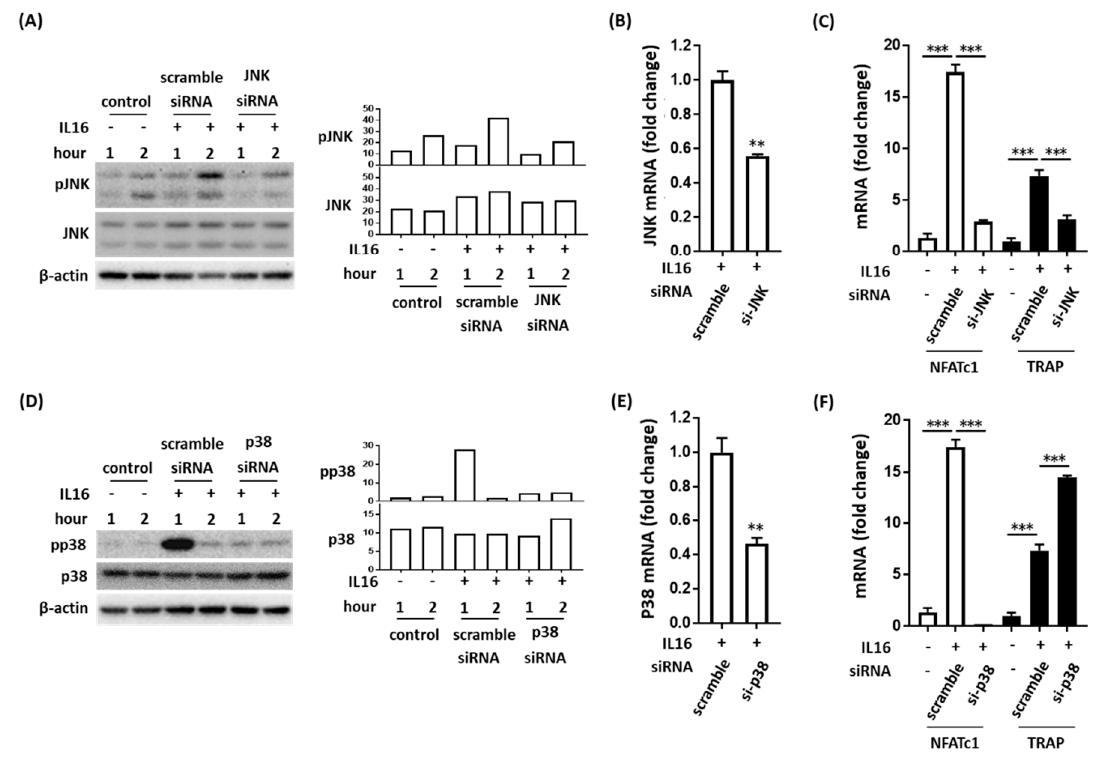
Figure 3. IL-16 increased the number of tartrate-resistant acid phosphatase (TRAP)-positive osteoclasts through the nuclear factor of activated T cell 1 (NFATc1) signaling pathway activated by c-Jun N-terminal kinases (JNK) but not by p38. ( A , B ) The specific siRNA of JNK inhibited IL-16-induced JNK phosphorylation and JNK mRNA expression in RAW264.7 cells; ( C ) The specific siRNA of JNK attenuated IL-16-induced NFATc1 and TRAP mRNA expression; ( D , E ) The specific siRNA of p38 MAPK inhibited IL-16-induced p38 MAPK phosphorylation and p38 MAPK mRNA expression in RAW264.7 cells; ( F ) The specific siRNA of p38 MAPK attenuated IL-16-induced NFATc1 mRNA expression and increased TRAP mRNA expression. Data are presented as means ± standard errors of the means. Analyses were conducted using two-way analysis of variance and then Bonferroni’s post hoc test. ** p < 0.01 and *** p <